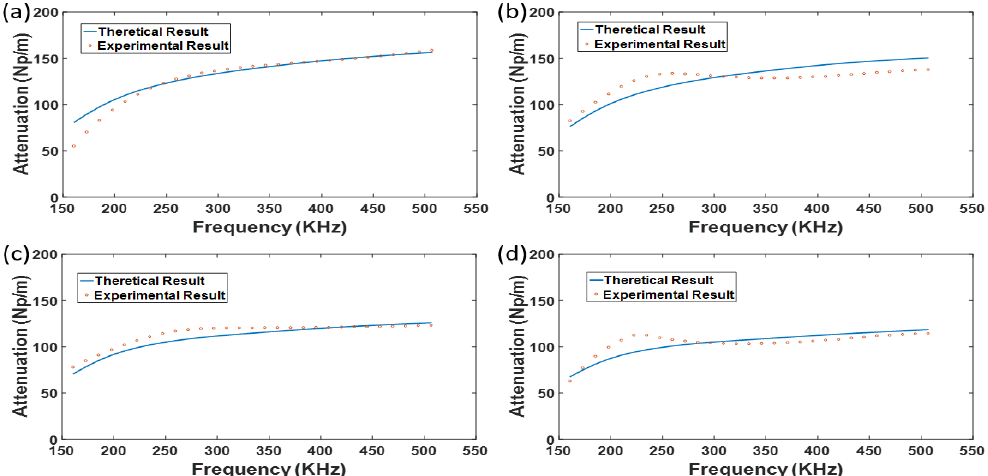
Figure 5. The comparison between theoretical and experimental attenuation during early stages ( a ) The comparison at Day 1; ( b ) The comparison at Day 3; ( c ) The comparison at Day 7; ( d ) The comparison at Day 14.